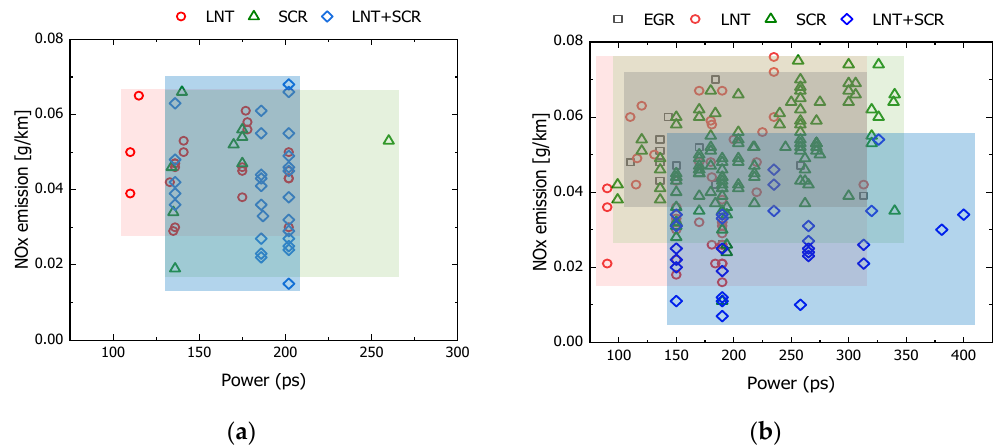
Figure 8. NO x emission characteristics according to after-treatment system and power for the domestic and imported vehicles in Korea. ( a ) Domestic vehicles; ( b ) Imported vehicles.